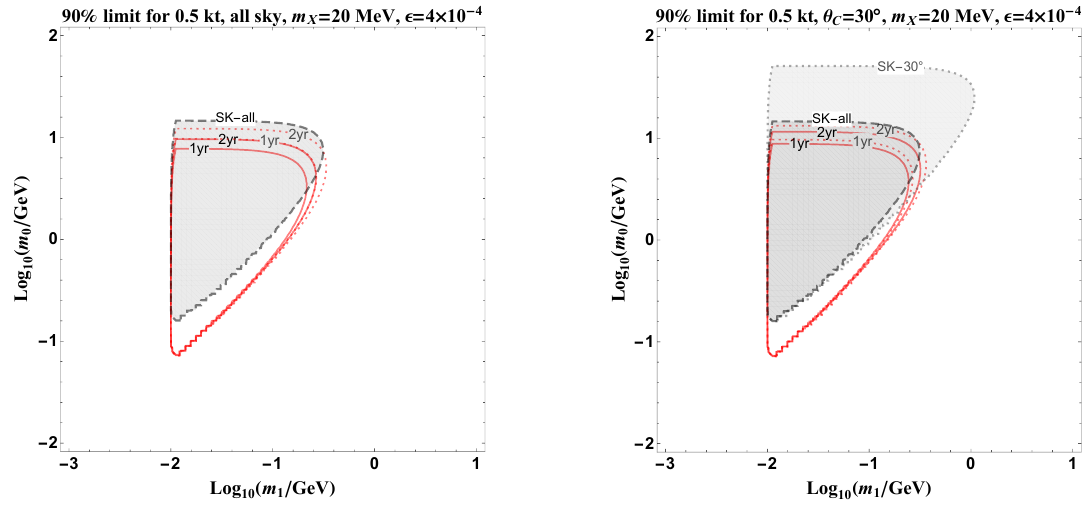
Figure 8 . The expected 90% exclusion bounds from 1-year and 2-year running of 0.5 kt- V (cid:12)d detectors for all sky (left panel) and 30 (cid:14) cone (right panel). The red-dotted curves are the same but using the improved estimation of neutrino backgrounds N 180 (cid:14) The gray-shaded areas are bounds from SK measurements as in (cid:12)gure 7.